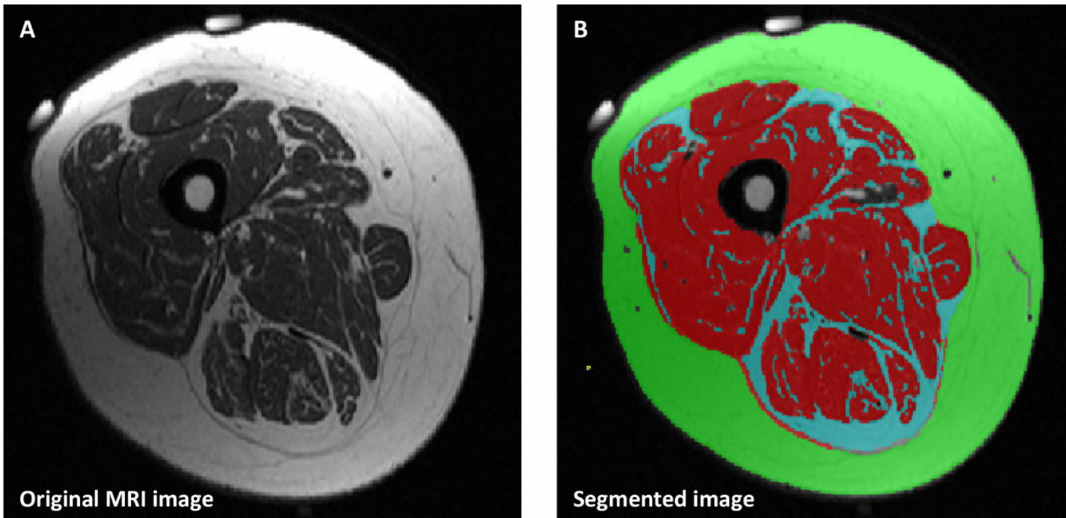
Figure 1. A sample of single-slice mid-thigh MRI image before ( A ) and after ( B ) segmentation. Structures in red: muscle, green: subcutaneous fat, blue: intermuscular